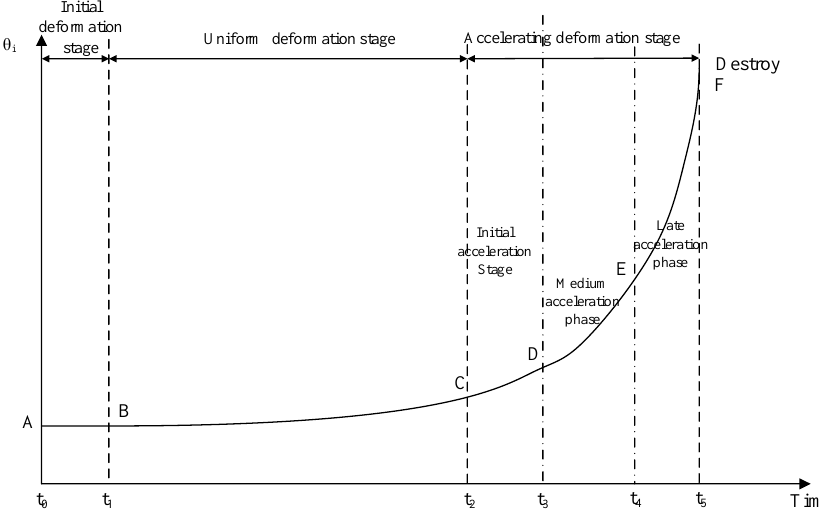
Figure 9. Sketch of the angle between the horizontal cumulative displacement and the vertical cumulative displacement.